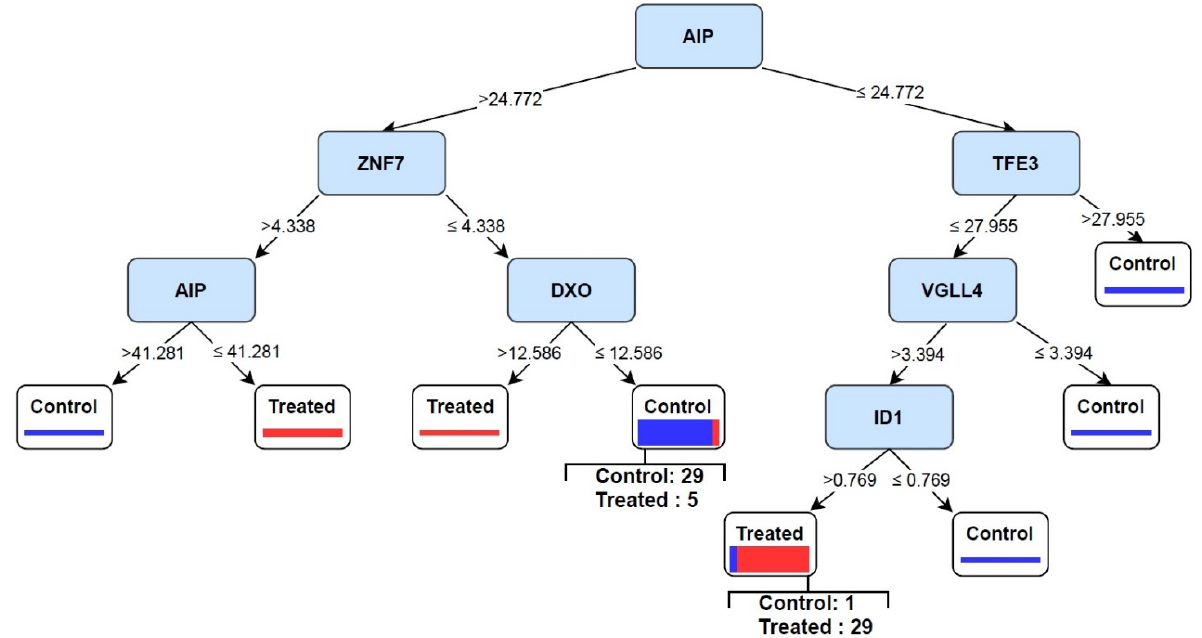
Figure 5. The AIP/TFE3/VGLL4/ID1 pattern was induced in 29 treated samples and one control case. In contrast, the AIP/ZNF7/DXO pattern was observed in 29 control and five treated samples.